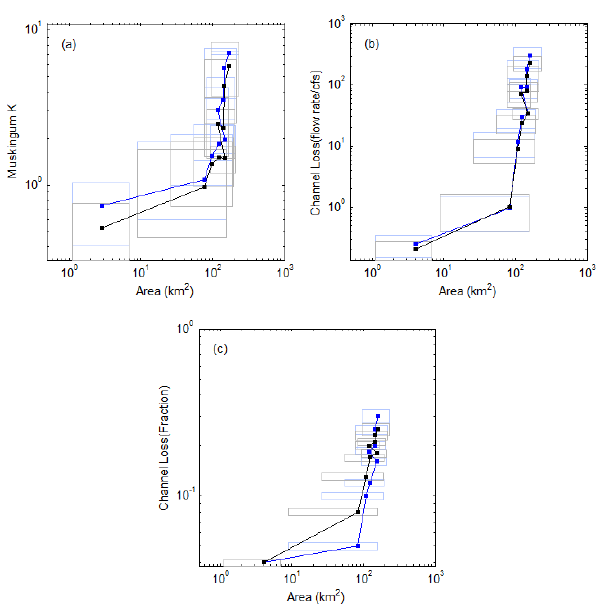
Fig. 9 Scaling property of HEC-HMS Calibrated parameters in the Channel 4 Fig. 9. Scaling property of HEC-HMS calibrated parameters in the